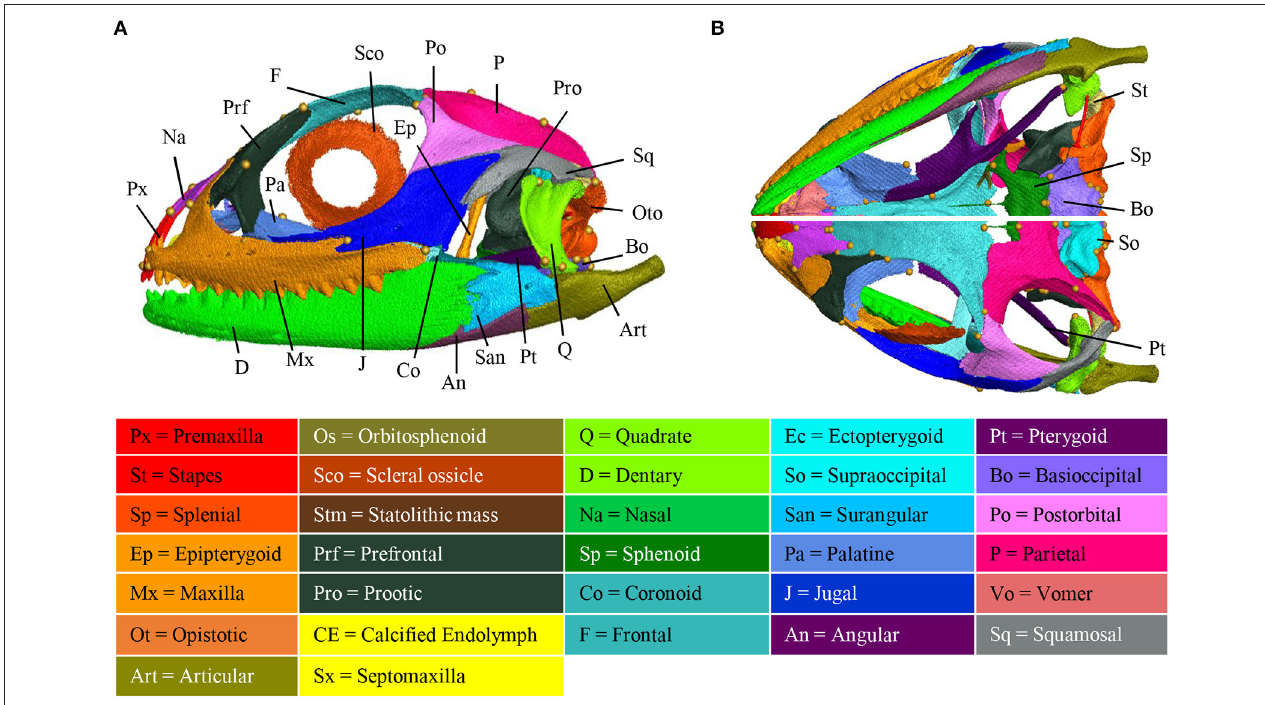
FIGURE 3 | Adult anatomy of the Pogona vitticeps skull. Lateral (A) , ventral ( B , top panel), and dorsal ( B , bottom panel) views of the skull of adult Pogona vitticeps . Pictures are based on 3D isosurface renderings and segmentation of individual bones with different colors (see color-coding in the bottom panel).